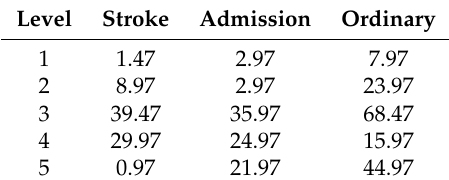
Figure 13. Adequacy of treatment of Stroke patients according to the Manchester Standard. Table 7. Waiting times in the Logs (in minutes).